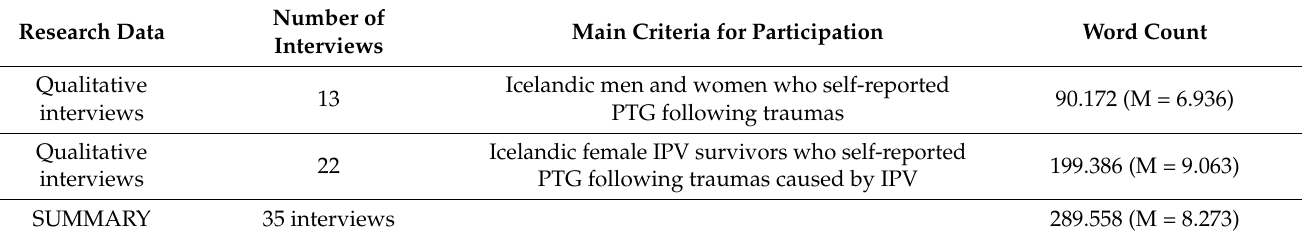
Table 3. Summary of research data collected by the first author, used to develop the theory in step